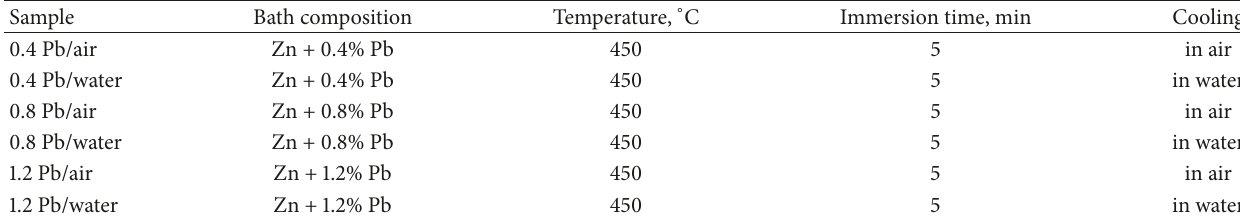
Table 1: Bath composition and galvanizing process